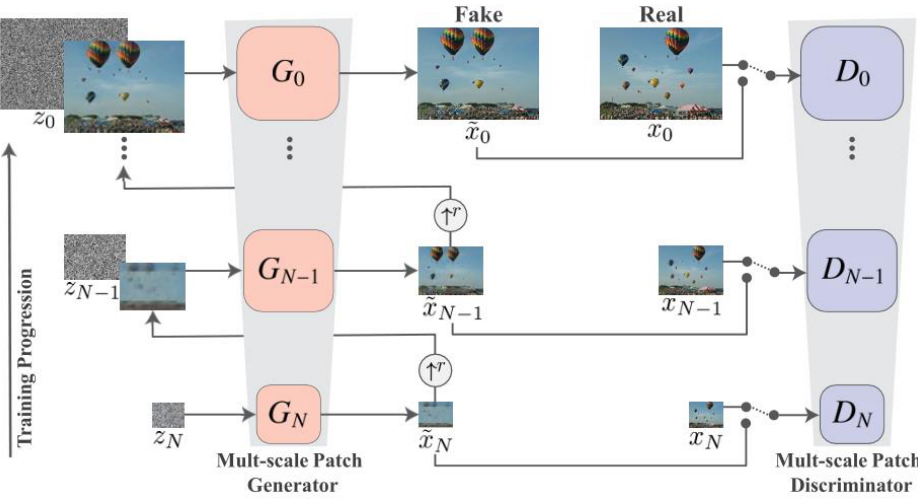
Figure 1. Basic structure of the SinGAN model.